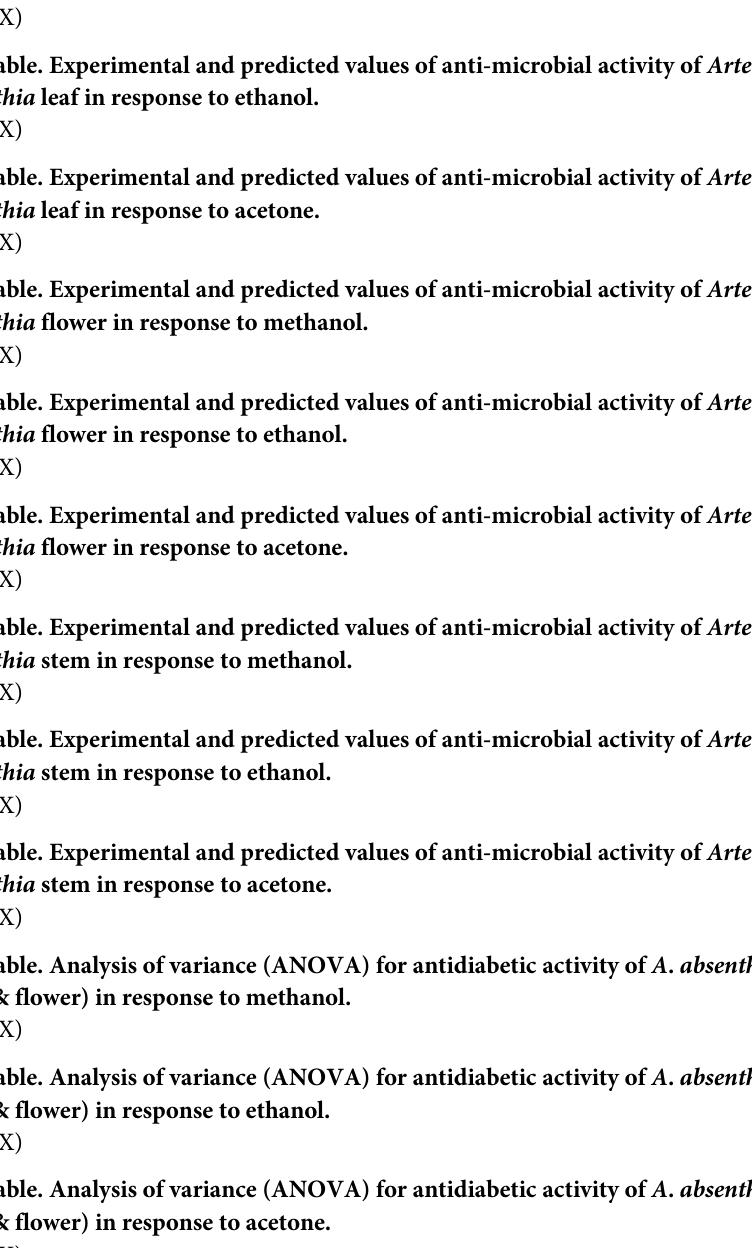
S8 Table. Analysis of variance (ANOVA) for antimicrobial activity of A . absenthia stem in response to ethanol. S9 Table. Analysis of variance (ANOVA) for antimicrobial activity of A . absenthia stem in response to acetone. S10 Table. Experimental and predicted values of anti-microbial activity of Artemesia absenthia leaf in response to methanol. S11 Table. Experimental and predicted values of anti-microbial activity of Artemesia absenthia leaf in response to ethanol. S12 Table. Experimental and predicted values of anti-microbial activity of Artemesia absenthia leaf in response to acetone. S13 Table. Experimental and predicted values of anti-microbial activity of Artemesia absenthia flower in response to methanol. S14 Table. Experimental and predicted values of anti-microbial activity of Artemesia absenthia flower in response to ethanol. S15 Table. Experimental and predicted values of anti-microbial activity of Artemesia absenthia flower in response to acetone. S16 Table. Experimental and predicted values of anti-microbial activity of Artemesia absenthia stem in response to methanol. S17 Table. Experimental and predicted values of anti-microbial activity of Artemesia absenthia stem in response to ethanol. S18 Table. Experimental and predicted values of anti-microbial activity of Artemesia absenthia stem in response to acetone. S19 Table. Analysis of variance (ANOVA) for antidiabetic activity of A . absenthia (Leaves, stem & flower) in response to methanol. S20 Table. Analysis of variance (ANOVA) for antidiabetic activity of A . absenthia (Leaves, stem & flower) in response to ethanol. S21 Table. Analysis of variance (ANOVA) for antidiabetic activity of A . absenthia (Leaves, stem & flower) in response to